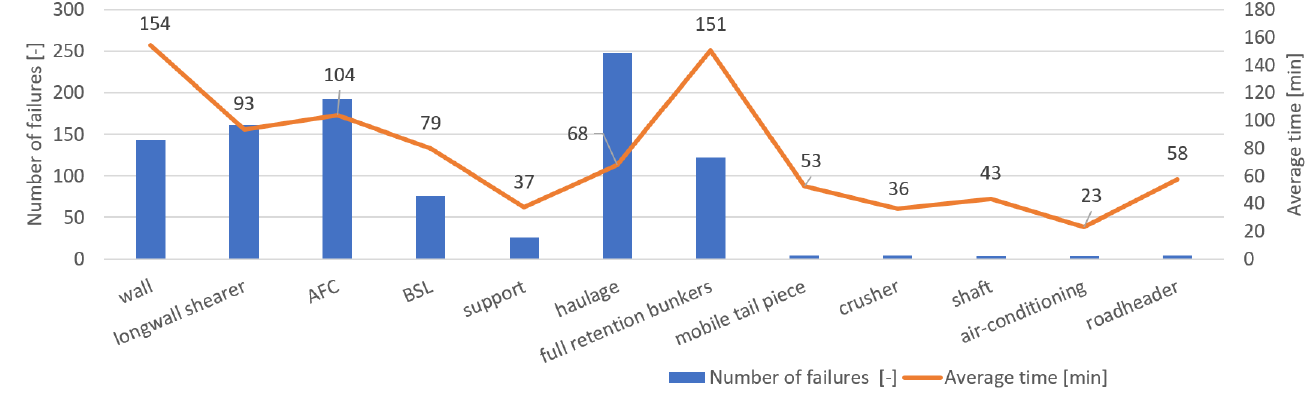
Figure 4. Number of failures and average duration of failures of shearer longwalls in total.